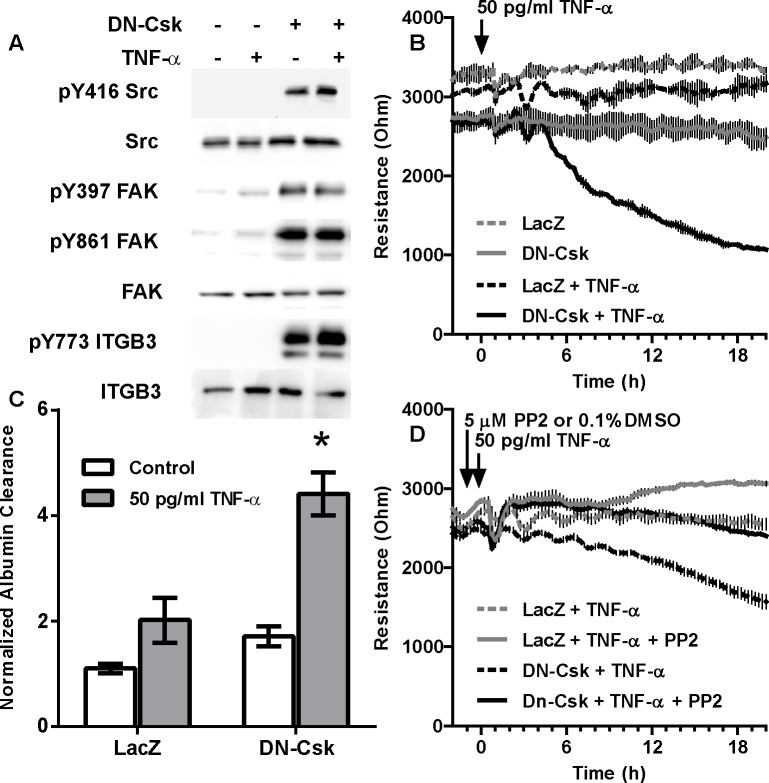
Constitutive activation of SFKs through expression of DN-Csk renders HDMEC susceptible to low doses of TNF-α.Cells were seeded at confluence and incubated for 72 hours. Then, growth media was replaced by low serum media and cells were infected with adenovirus to express either LacZ (control) or DN-Csk. After another 16 h, cells were treated with low-dose TNF-α. A, Western blot analysis demonstrating the increased tyrosine phosphorylation at multiple SFK substrates. B, TEER measurements on ECIS electrodes. C, FITC-Albumin permeability assay on Transwell chambers. D, TEER of cells pretreated with either DMSO or PP2 for 30 minutes prior to TNF-α addition. Results are representative of at least three independent experiments. Notice that the synergistic effect of DN-Csk expression concurrently with a low-dose TNF-α can be prevented by the SFK inhibitor PP2. Data presented as mean±SEM (each experiment performed in duplicate). Asterisk, p<0.05 (Two-way ANOVA and Tukey’s multiple comparison post-hoc test). Bar graphs with data presented as mean±SEM and statistical analysis of TEER for the 20 h time point corresponding to B and D are shown in S6C and S6D Fig respectively.